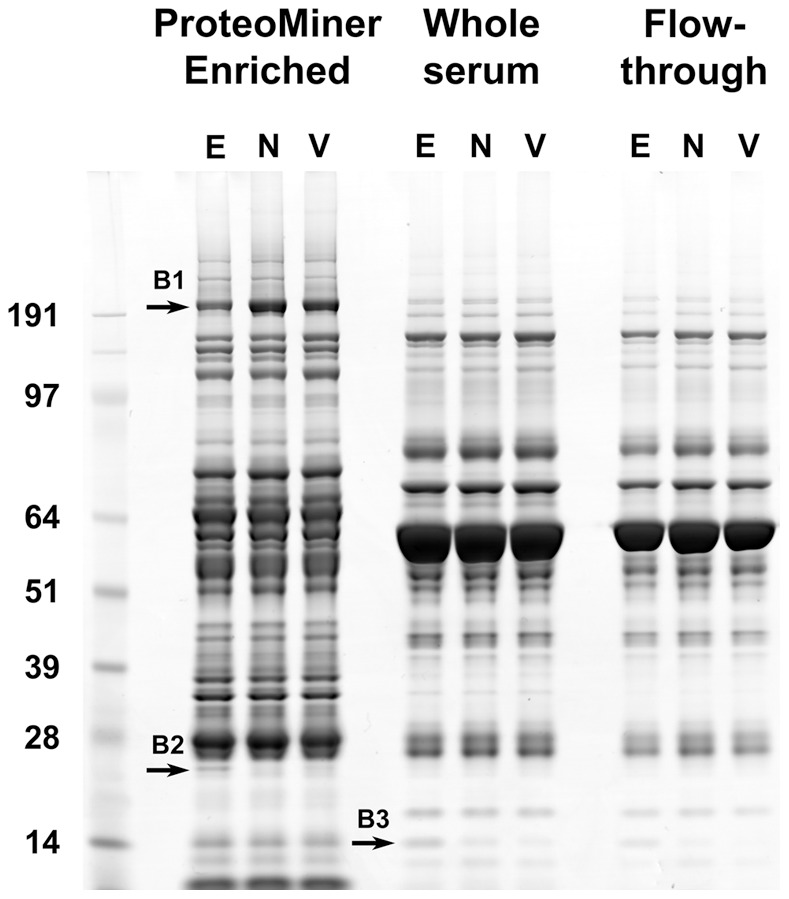
1D SDS-PAGE of ProteoMiner™ affinity-purified serum, alongside the original whole sera and flow-through, from women undergoing surgical management of EP (E), surgical management of NVIUP (N) and surgical termination of VIUP (V).Note the increased complexity and reduction in high abundance proteins in the enriched fractions. Three bands (B1, B2 and B3) appeared differentially expressed and were submitted for PMF.